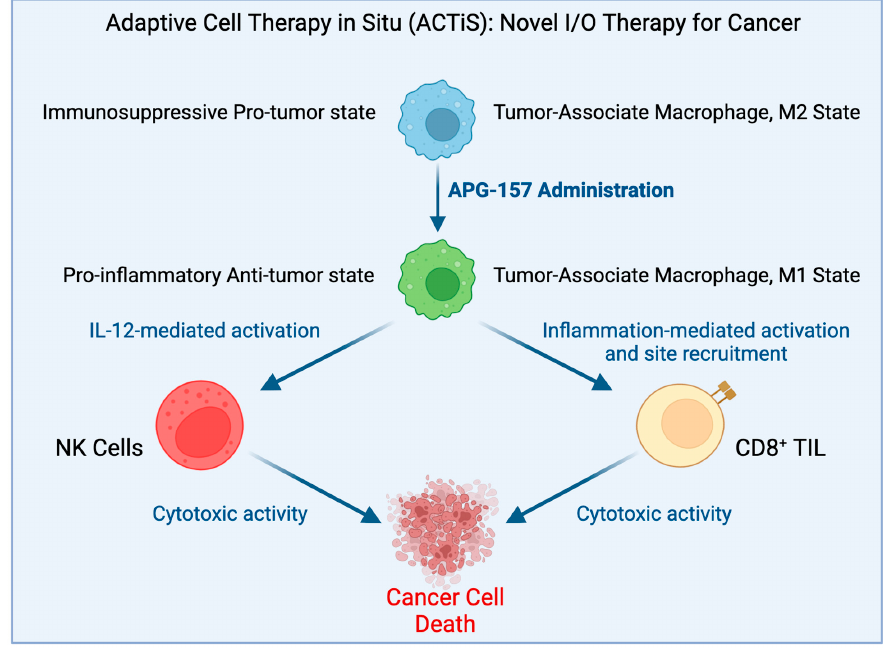
Figure 2. Proposed hypothesis for how APG-157 works.